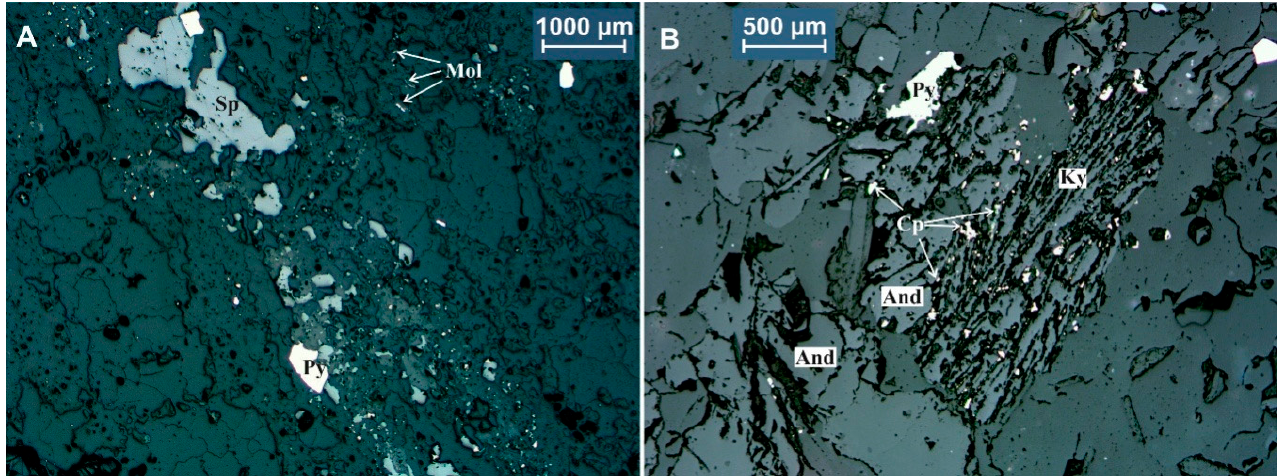
Figure 8. Quartz–calcite–epidote veinlet with sphalerite–pyrite mineralization ( A ) and kyanite with disseminated chalcopyrite along the cleavage, Pellapahk Cu-Mo deposit ( B ). Polished section photo, plane polarized light. Cp—chalcopyrite; Mol—molybdenite;Py—pyrite;Sp—sphalerite.